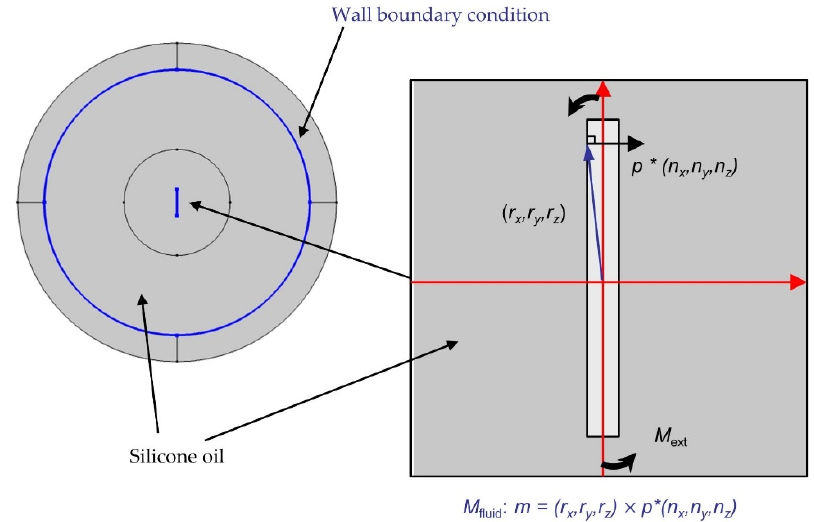
Figure 7. Overview of the specified simulation model, with the individual components considered and the resulting Moment ( M ext ) caused by spatial dependent fluid pressure ( p ( r x , r y , r z )).